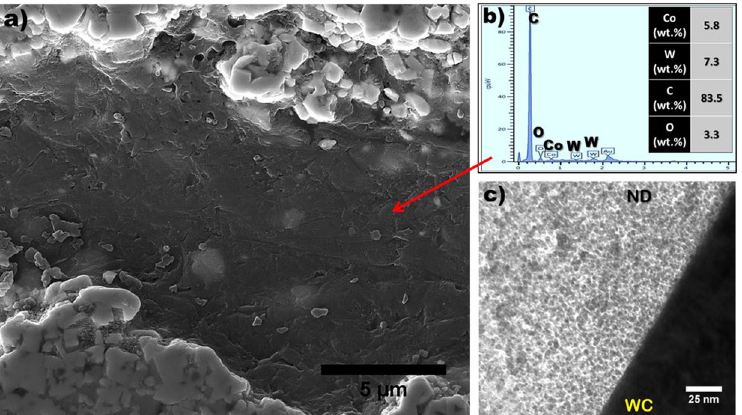
Figure 4. ( a ) SEM of interior of high aspect ratio pore in WC-Co-10ND sample, ( b ) EDS of pore walls indicating high carbon content, ( c ) TEM of smooth interface between agglomerated ND particles and WC particle, ND can be seen to be closely adhered to the WC